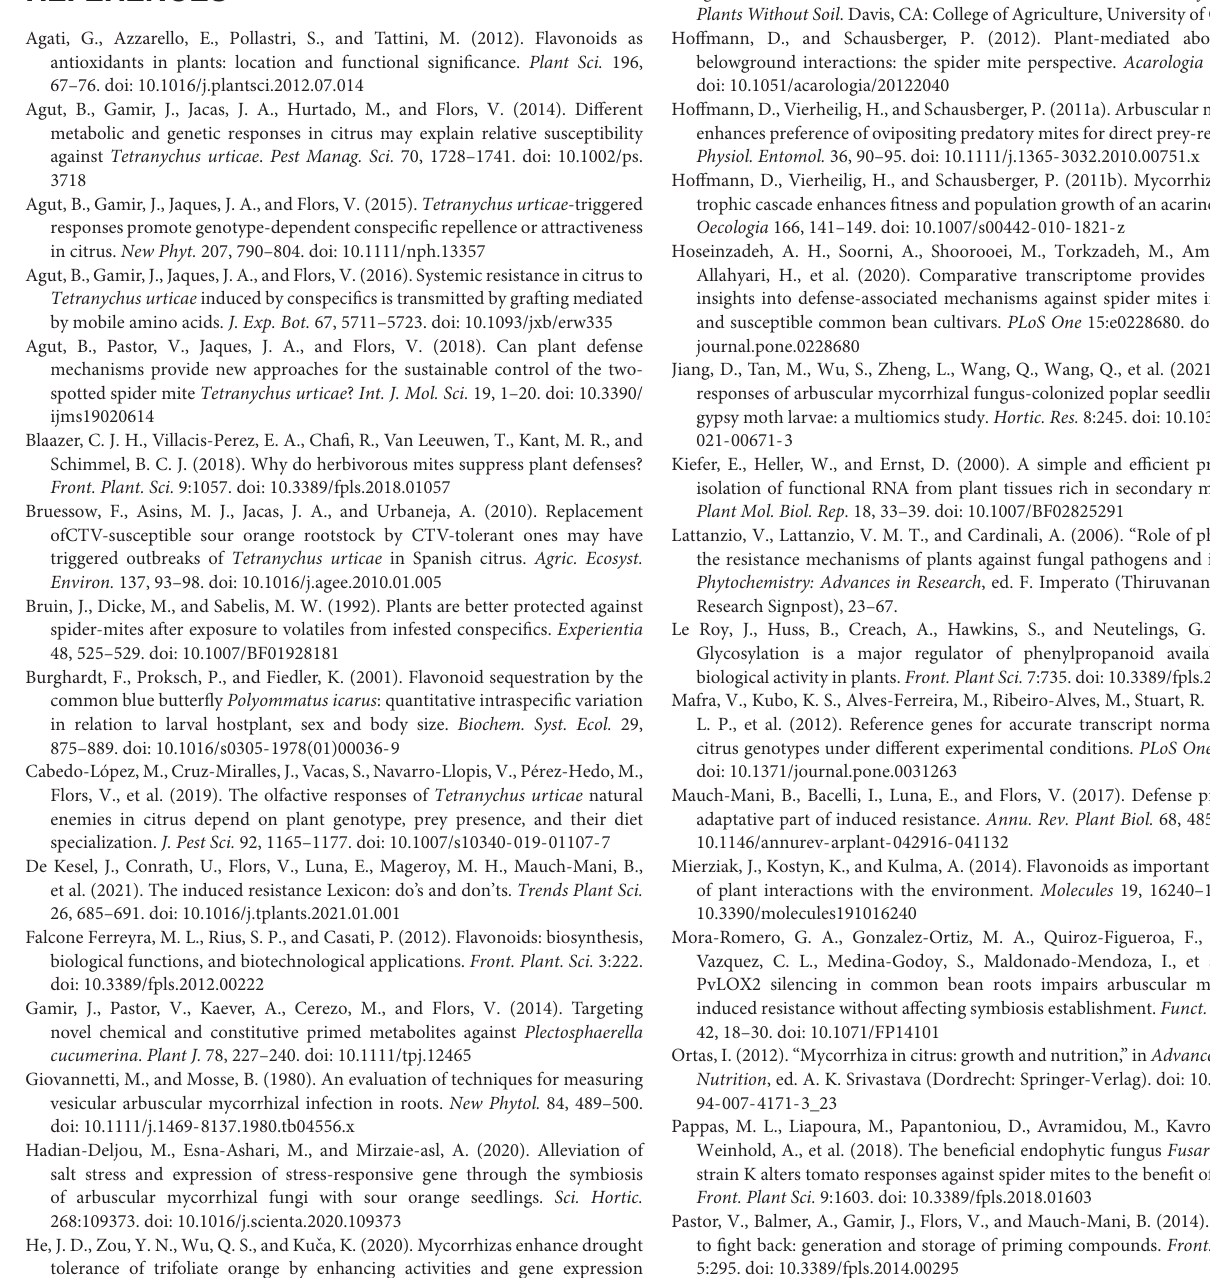
from 6 individual plants was employed for each combination. Three independent and two technical replicates were randomly performed ( n = 5). Supplementary Figure 5 | Systemic responses of C. aurantium mycorrhizal plants against T. urticae after distal treatment. Relative damaged area on leaf surface. Half of the mycorrhizal and non-mycorrhizal plants were previously locally infested with 10 adult females per each plant. 72 h after the first treatment, all the plants were infested with 5 mites per systemic leaf (2 leaves per plant). 72 h after the second infestation, the damage rate was determined on the